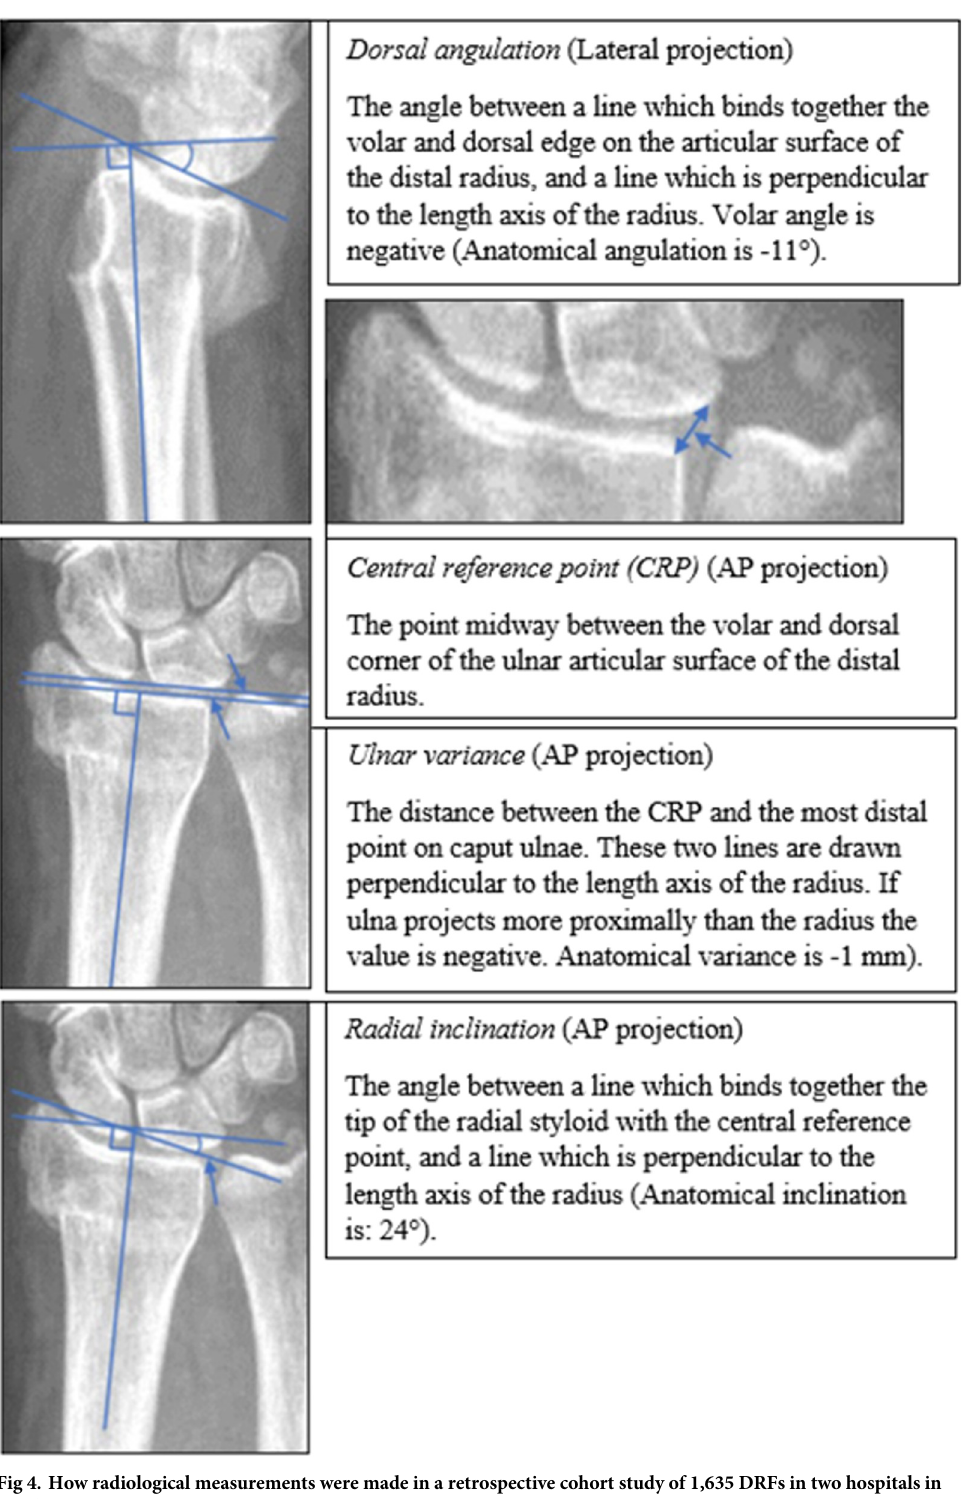
PLOS ONE | https://doi.org/10.1371/journal.pone.0260296 February 10,